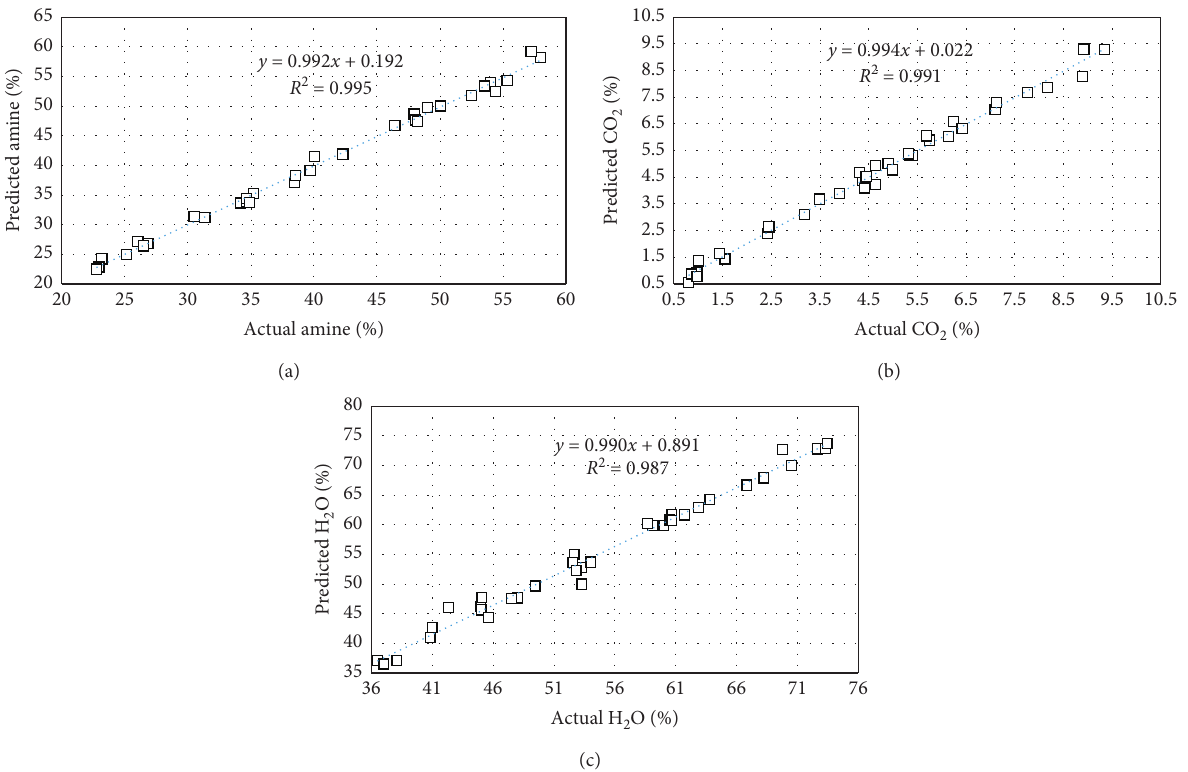
Figure 4: Calibration model and coefficient of determination ( R 2 ) for (a) amine, (b) CO